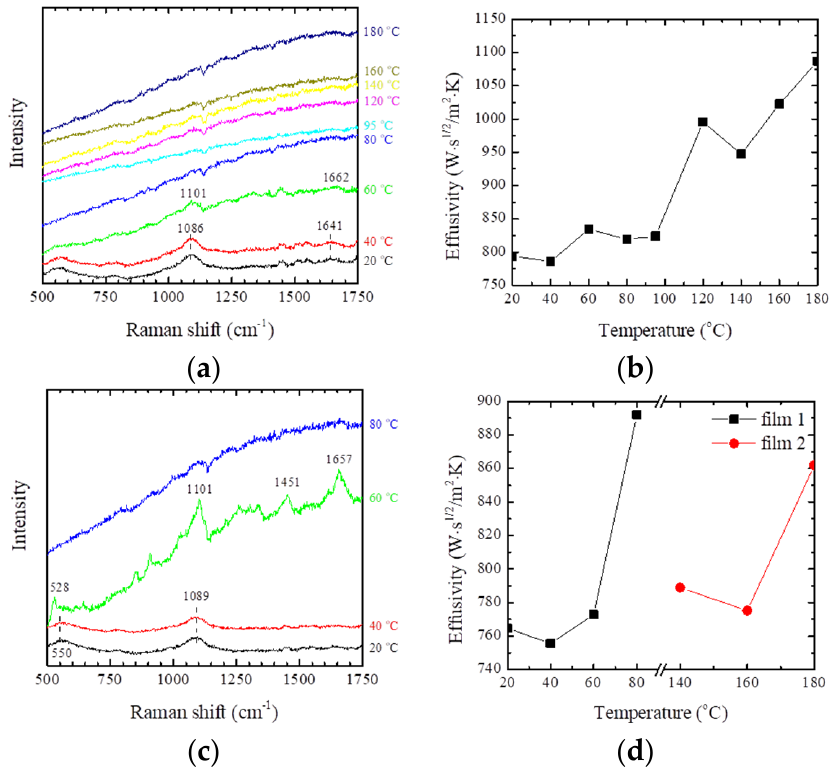
Figure 4. Thermal and structural characterization of spider silk protein film: ( a ) Raman spectra and ( b ) PT determined thermal effusivity of N. clavipes spider silk protein film; ( c ) Raman spectra and ( d ) PT determined thermal effusivity of L. Hesperus spider silk protein film. Reprinted with permission from Ref. [36], Copyright (2022), Elsevier.